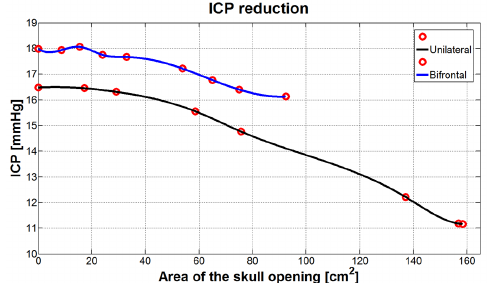
Figure 5. ICP reduction in the function of skull opening area.